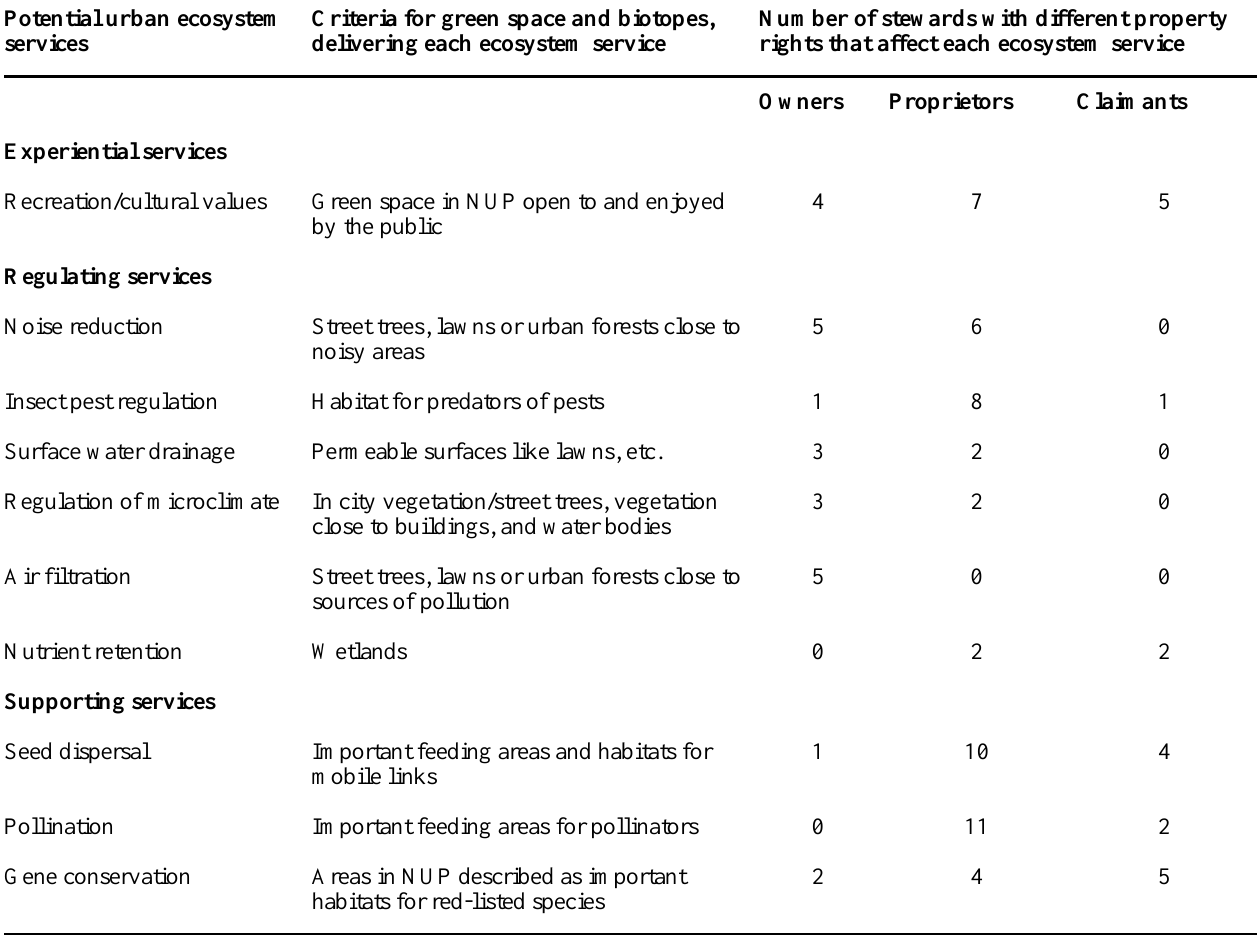
Table 2 . Potential ecosystem services generated by urban green space of the NUP, and the number of local stewardship associations involved in managing and sustaining them Potential urban ecosystem Criteria for green space and biotopes, Number of stewards with different property services delivering each ecosystem service rights that affect each ecosystem service